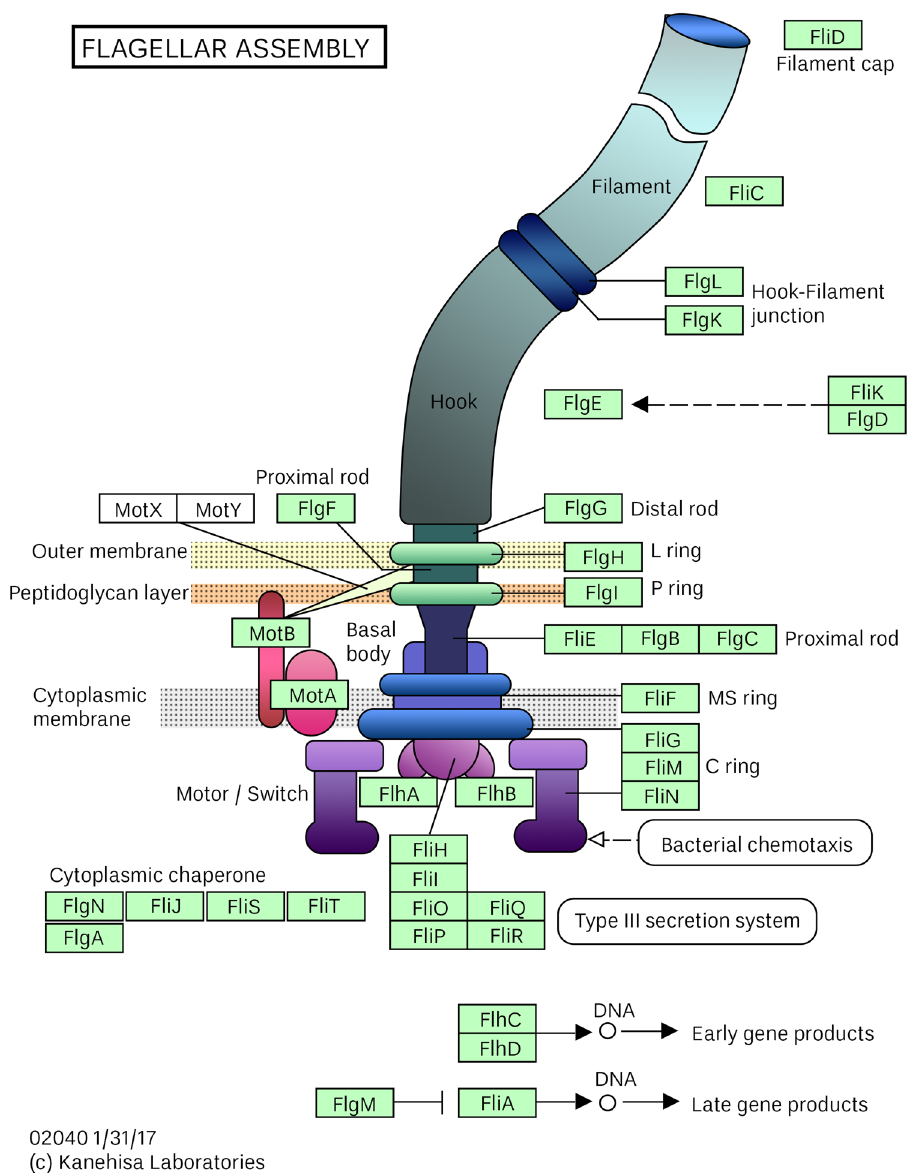
Fig. 6 Bacterial fl agellar motor ( E. coli ) with associated protein components. Eco02040 reprinted with modi fi cation under the CC BY 4.0 License (https://creativecommons.org/licenses/by/4.0/) based on KEGG, Kanehisa et al. 88